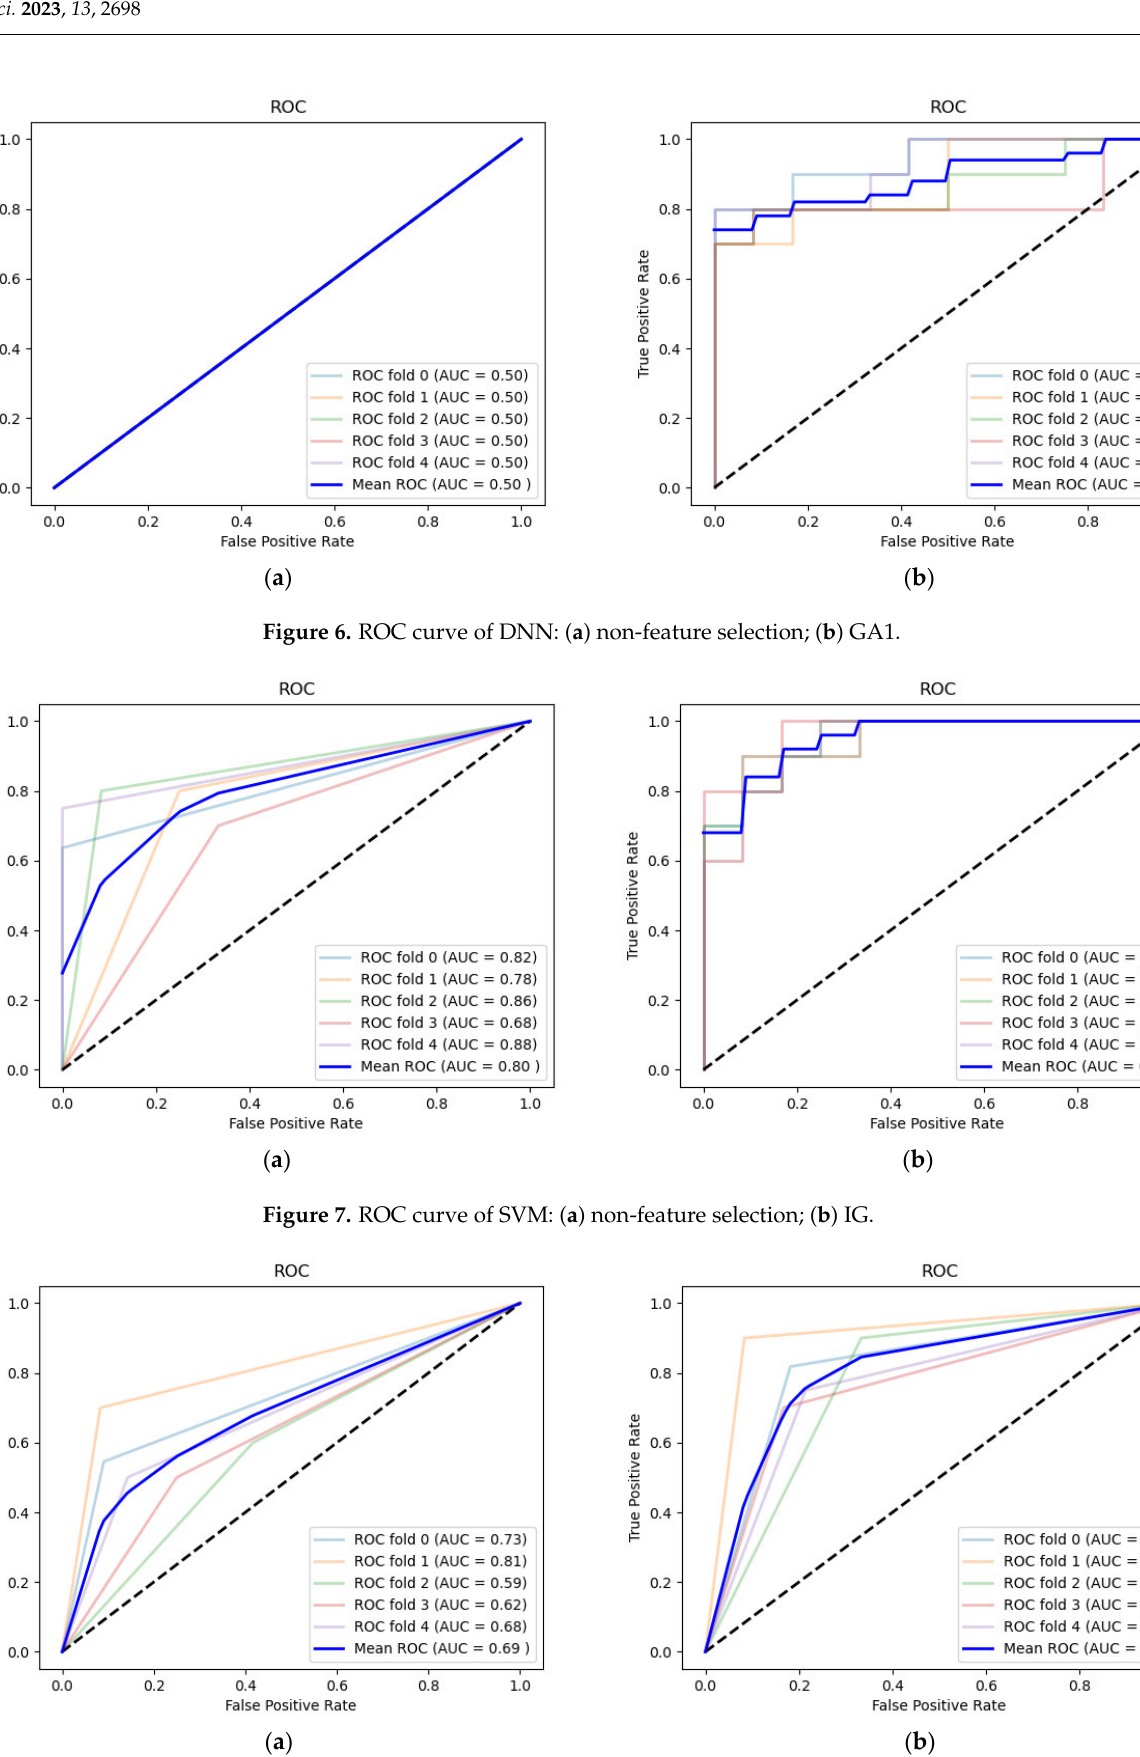
Figure 5. ROC curve of XGBoost: ( a ) non ‐ feature selection; ( b ) IG.